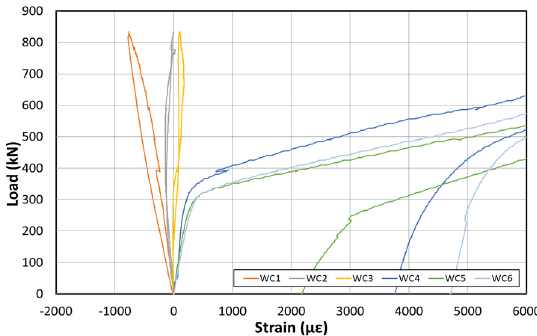
Figure 15. Load–displacement curve after reinforcement based on the EP method. Figure 16. Concrete strain curve at the center after reinforcement based on the EP method.